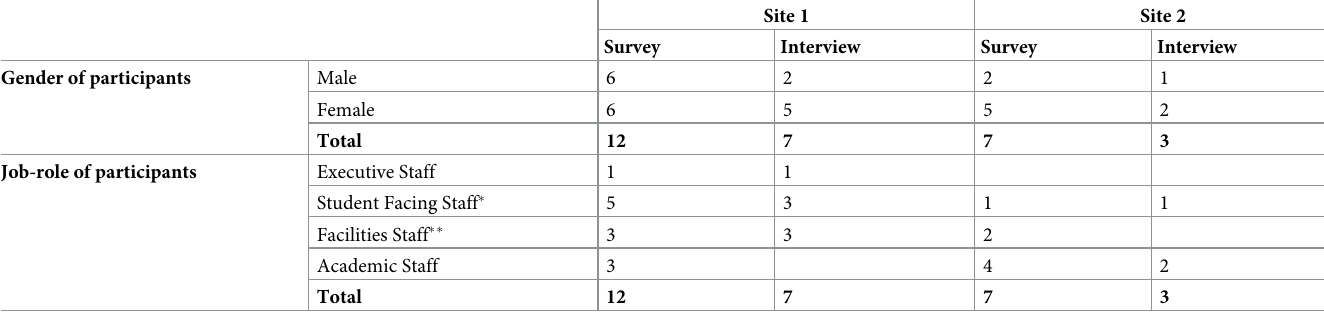
Table 1. Study participants by gender, job-role, and site of